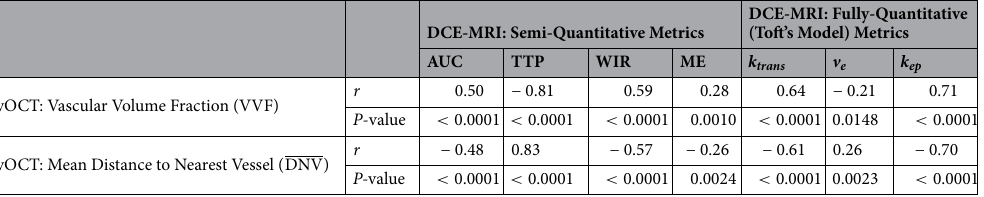
Table 2. Spearman correlation coefficients for svOCT and DCE-MRI